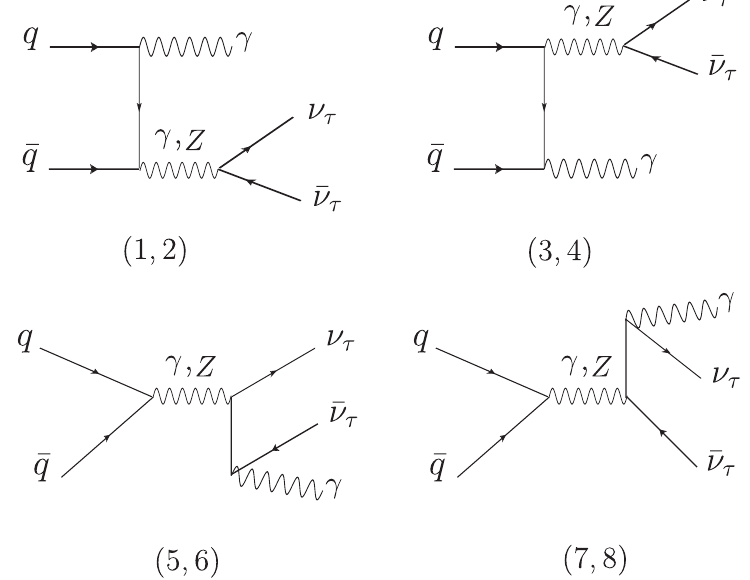
Figure 1: The Feynman diagrams for the processes q ¯ q → ( γ , Z ) → ν τ ¯ ν τ γ